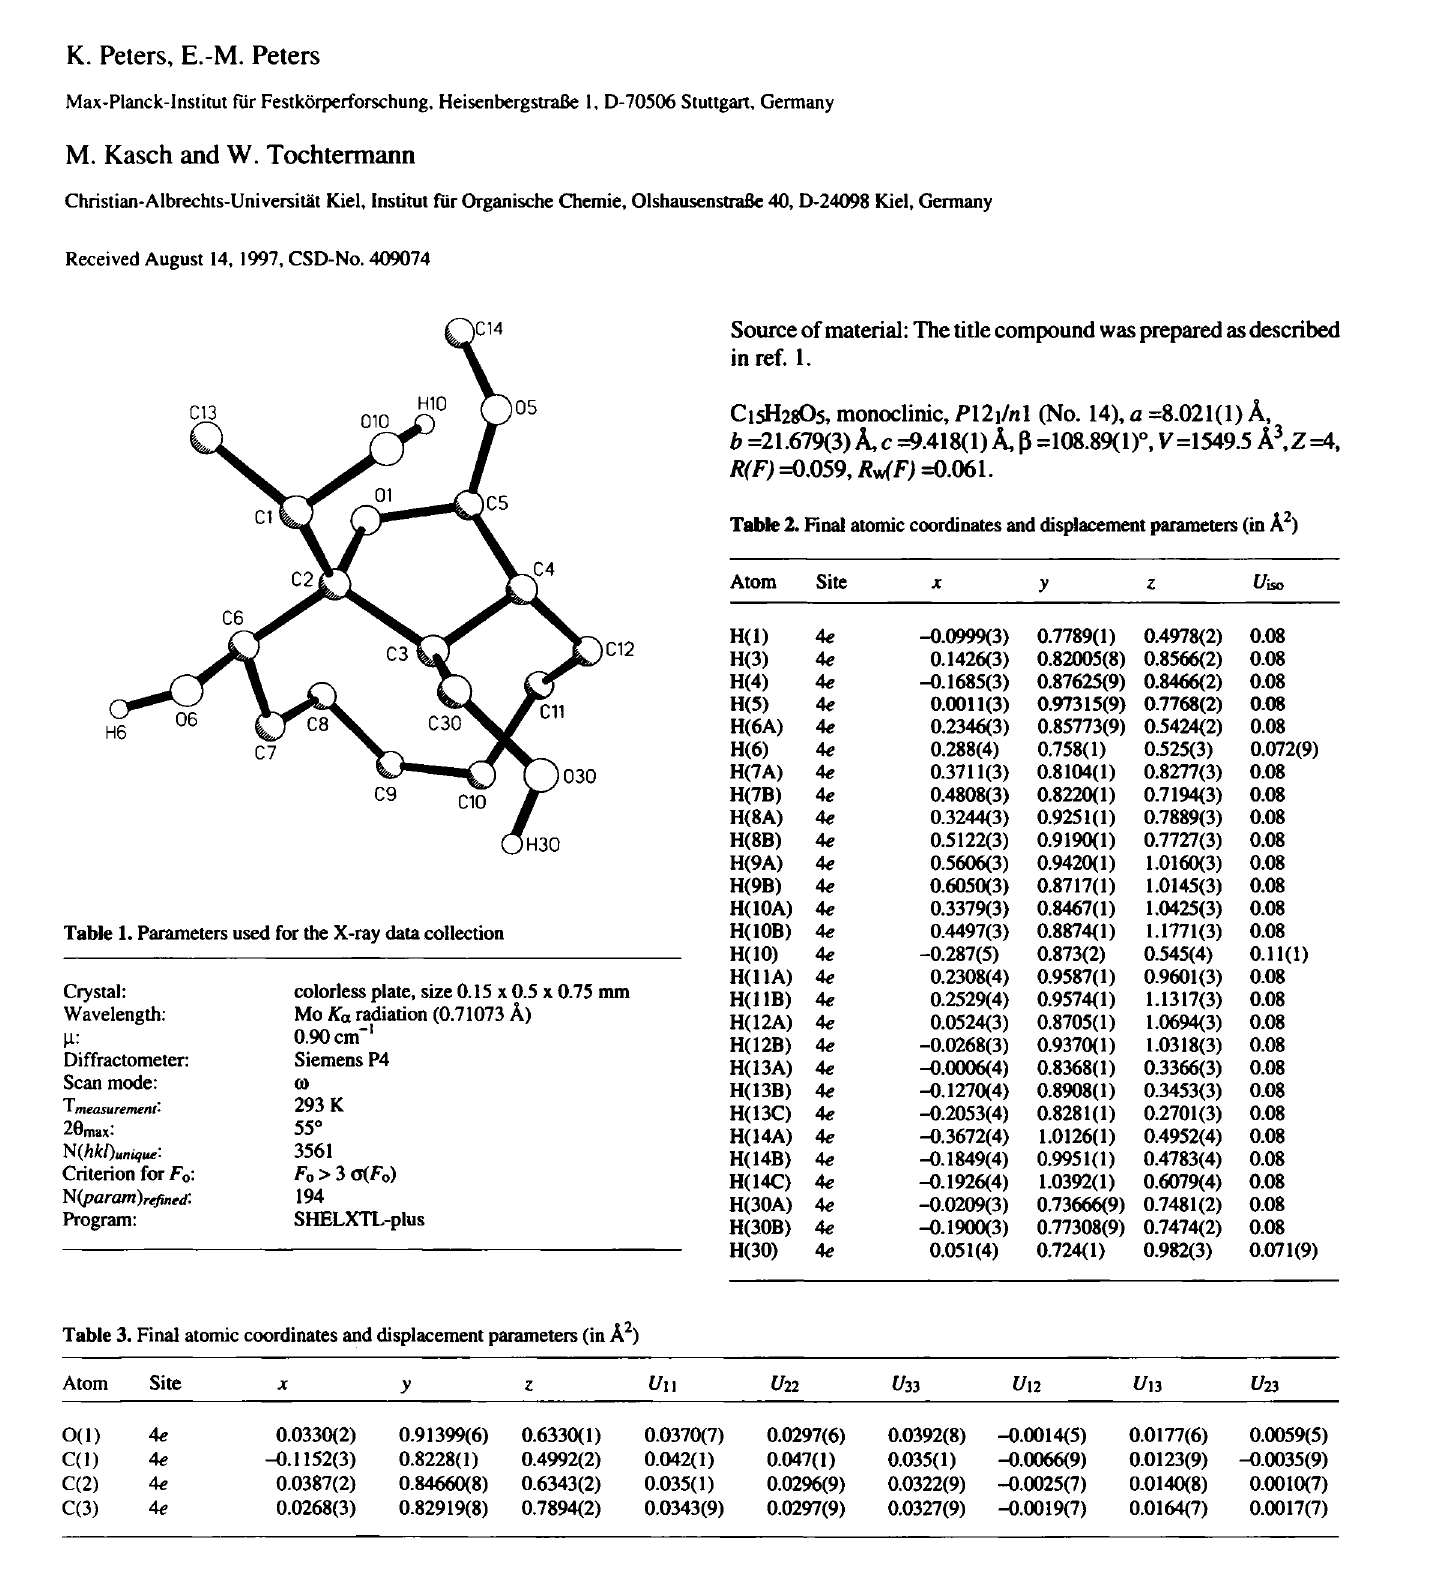
Source of material: The title compound was prepared as described inref. 1.